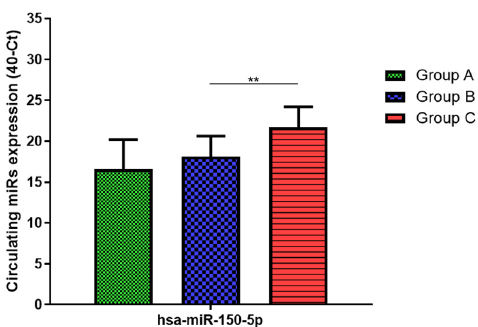
Figure 6. Serum levels of hsa-miR-150-5p in HNW (Group A), MANW (Group B) and HNAO (Group C). Results were shown as means ± SD. The statistical tests used in these analyses were one-way analysis of variance using Kruskal–Wallis test followed by Dunn’s Multiple Comparison Test. ** p < 0.01.